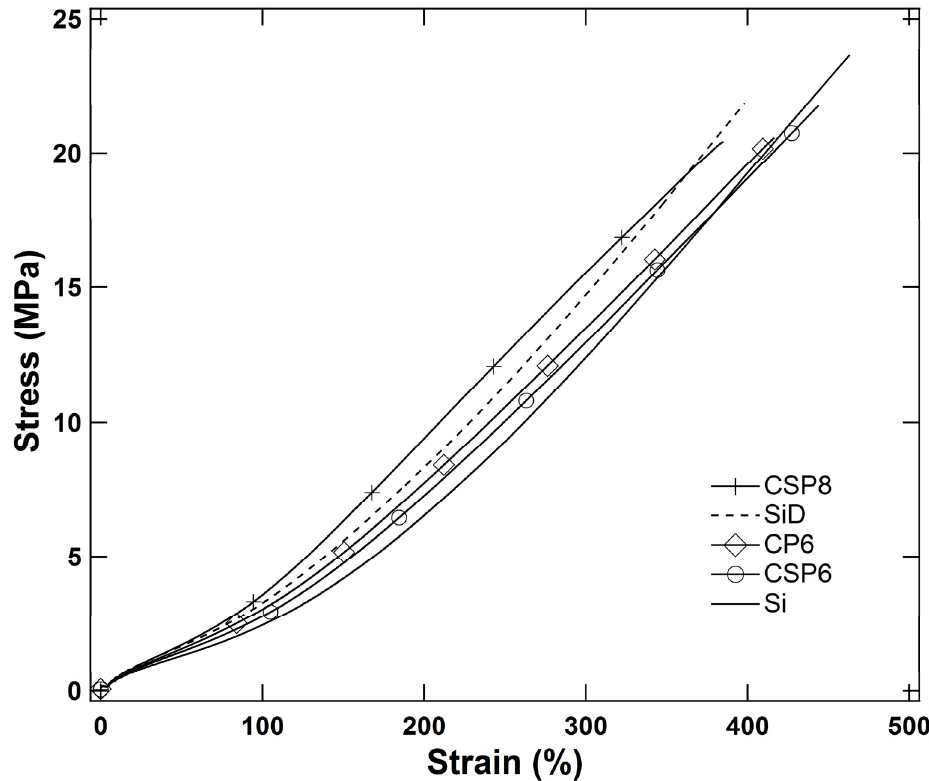
Figure 5. Tensile properties of rubber composites. Si = silica reinforced composite. SiD = silica reinforced composite with 1 phr DPG (1.3-diphenylguanidine).